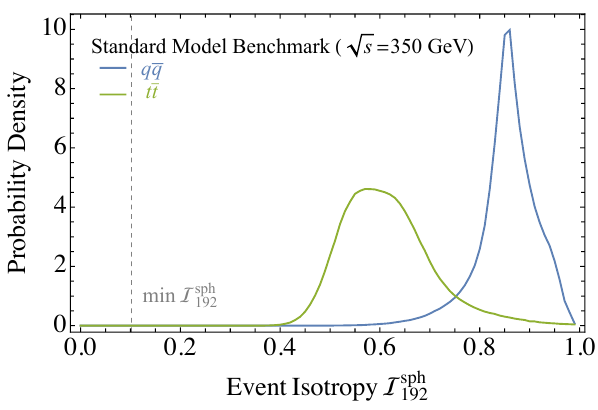
Figure 1 . Event isotropy distributions for e + e − → q ¯ q and e + e − → t ¯ t (hadronic decays only) at a center-of-mass energy just above the t ¯ t threshold. The distance measure eq. (1.3) gives higher I sph values than the corresponding plot in ref.